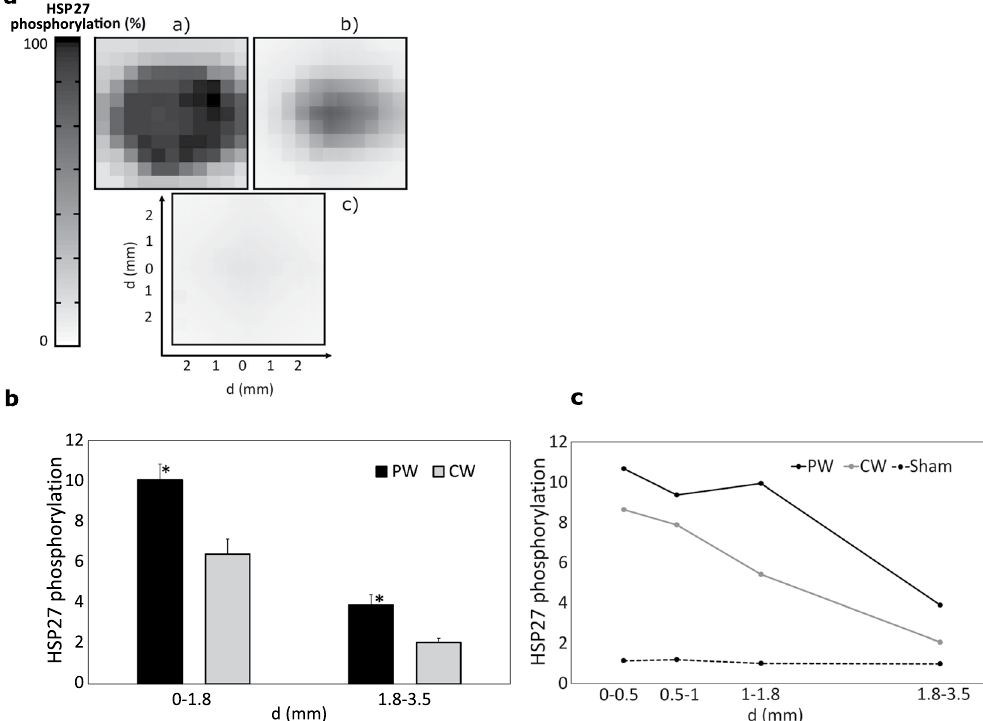
Figure 4. Phosphorylation of HSP27 after PW and CW exposure with the same average temperature rise. (a) Spatial distribution of the normalized intensity of the HSP27 phosphorylation for ( a ) PW, ( b ) CW, and ( c ) sham exposures. ( b ) Phosphorylation of HSP27 analyzed cell-by-cell 6 h post exposure shown as mean values (n = 3) ± SEM normalized to the sham. The data are averaged over the areas around the center of the well (i.e. 0–1.8 mm denotes the data averaged over the area with the radius of 1.8 mm, and 1.8–3.5 denotes the data averaged over 1.8 mm to 3.5 mm from the center). Asterisk ( * ) indicates statistical significance at p < 0.05. ( c ) The same data shown for the averaging with higher spatial